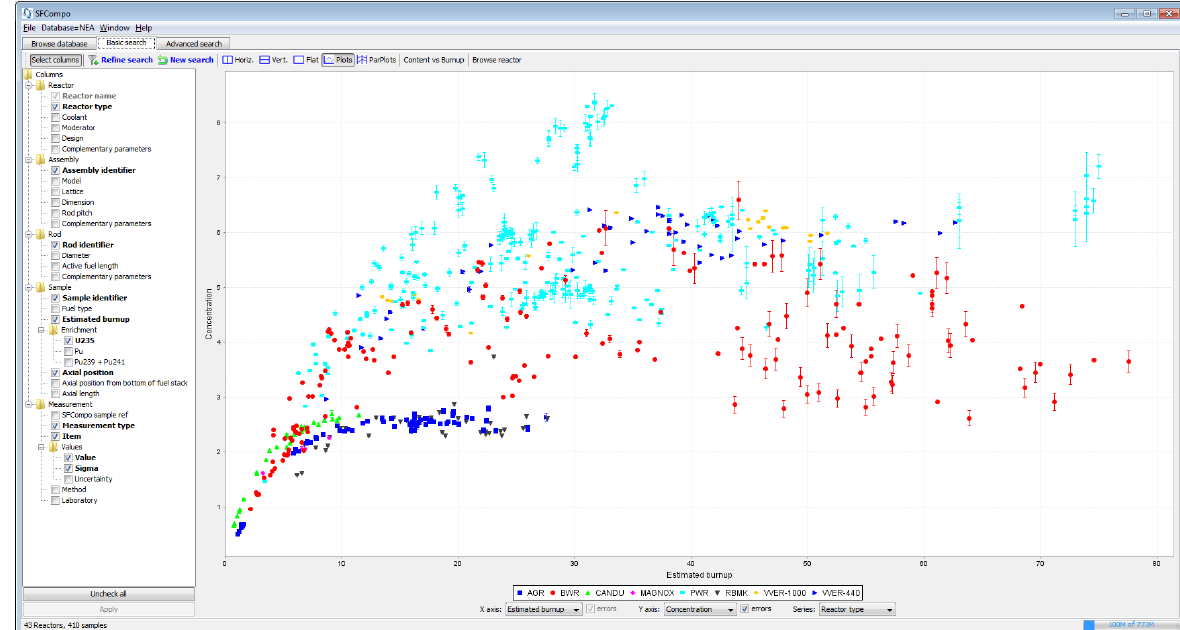
Figure 1. SFCOMPO 2.0 data visualization example: 239 Pu content by reactor